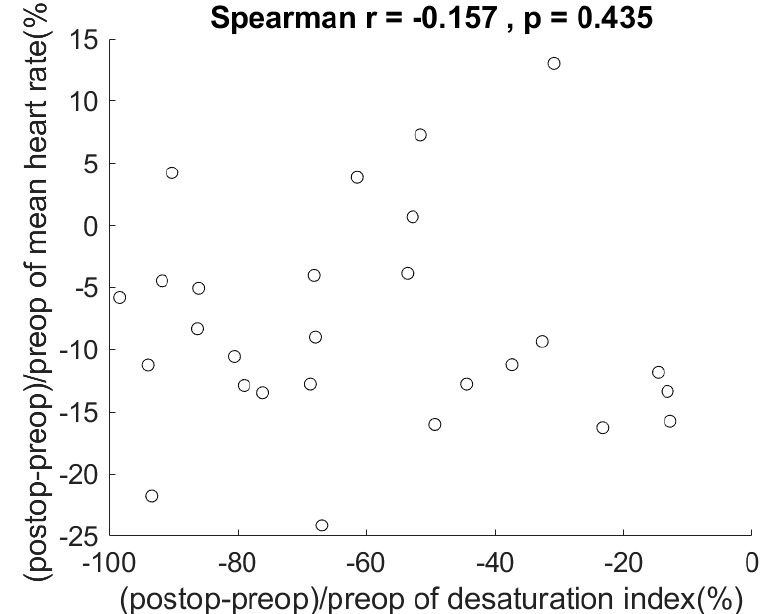
Figure 6. Scatter plot and correlation of change in desaturation index (defined here as (postoperative– preoperative)/preoperative desaturation index) vs. change in mean heart rate (defined here as (postoperative–preoperative)/preoperative mean heart rate). This shows that the change in mean heart rate was not related to the change in desaturation index.